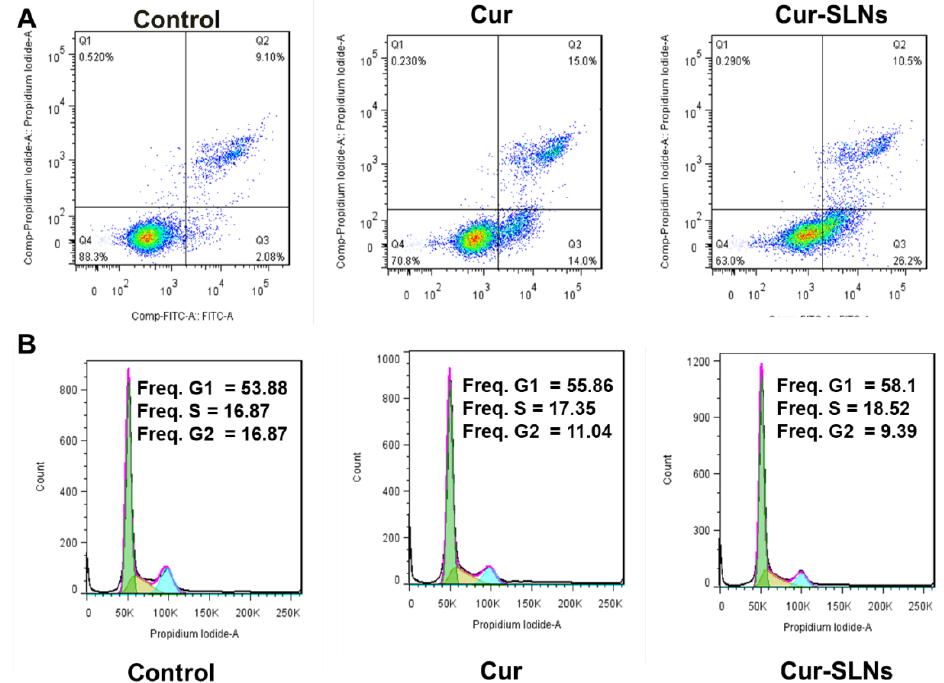
Figure 5. ( A ) Apoptosis and ( B ) cell cycle were analyzed in SKBR3 cells after 24 h treatment with curcumin and Cur-SLNs.